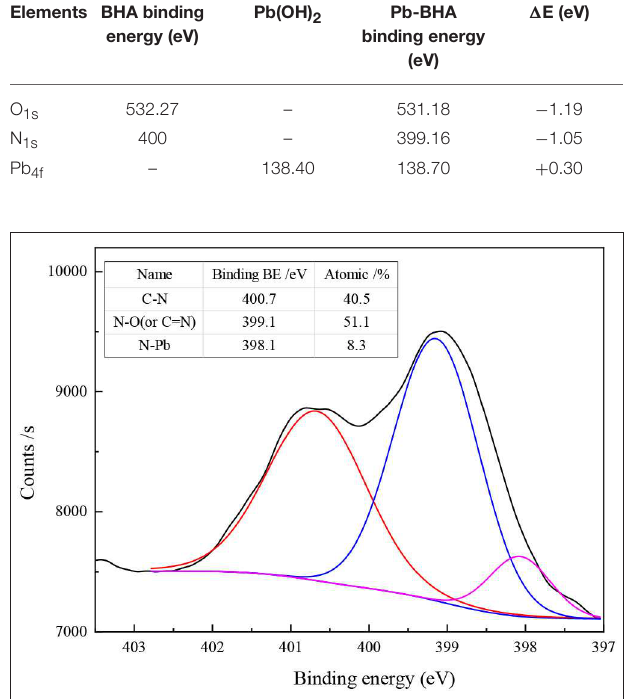
FIGURE 5 | N1s spectra of Pb-BHA complexes.